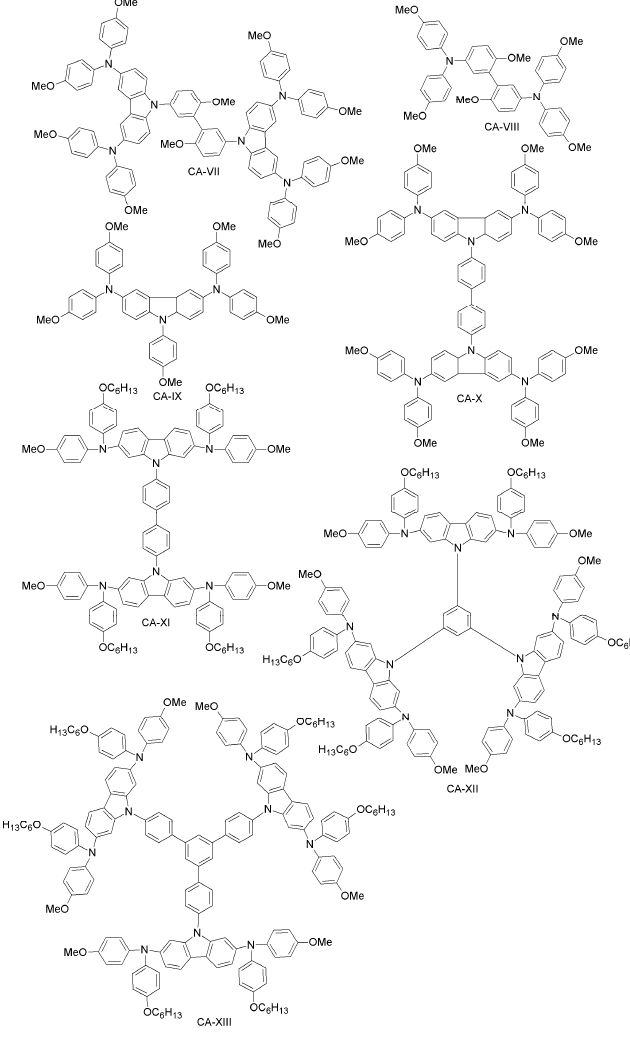
Figure 15. Carbazole-based HTMs (2).